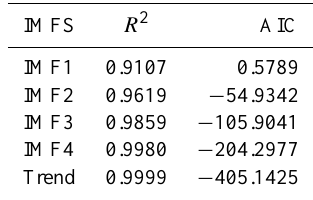
Table 2. R 2 and AIC value of simulation models for the IMFs and trend of